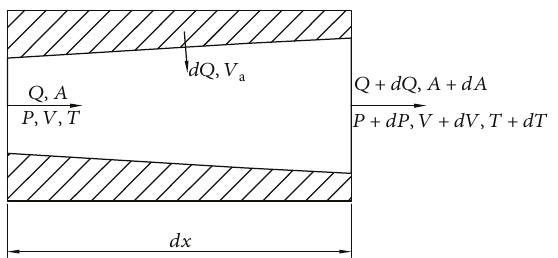
Figure 1: 1D control volume of the combustion